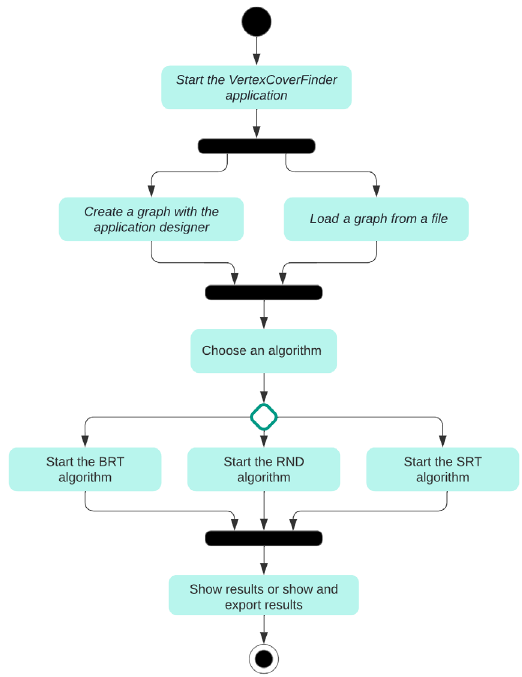
Fig. 6. Activity diagram for the VertexCoverFinder